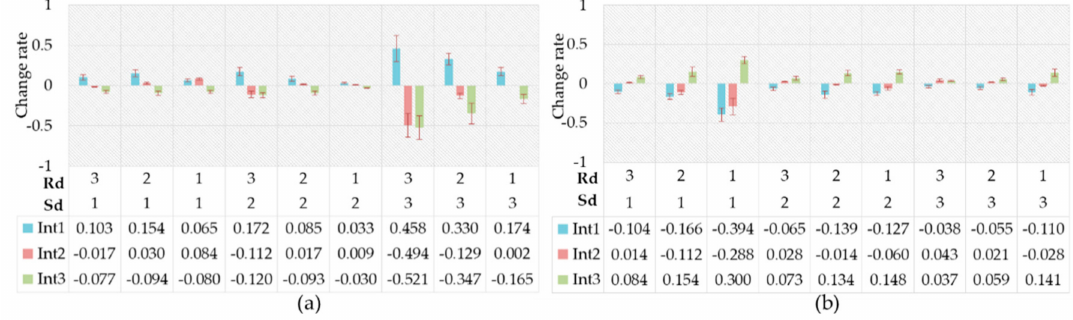
Figure 17. Change rates of driving intention probability. ( a ) Caused by helplessness; ( b ) Caused by contempt.